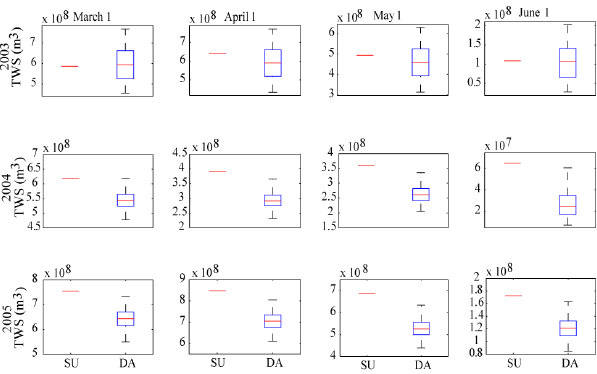
Fig. 5. Comparison of the total water stored (TWS) as snow pro- duced by the spin-up (SU) and data assimilation (DA) for the four forecast dates summed across all 15